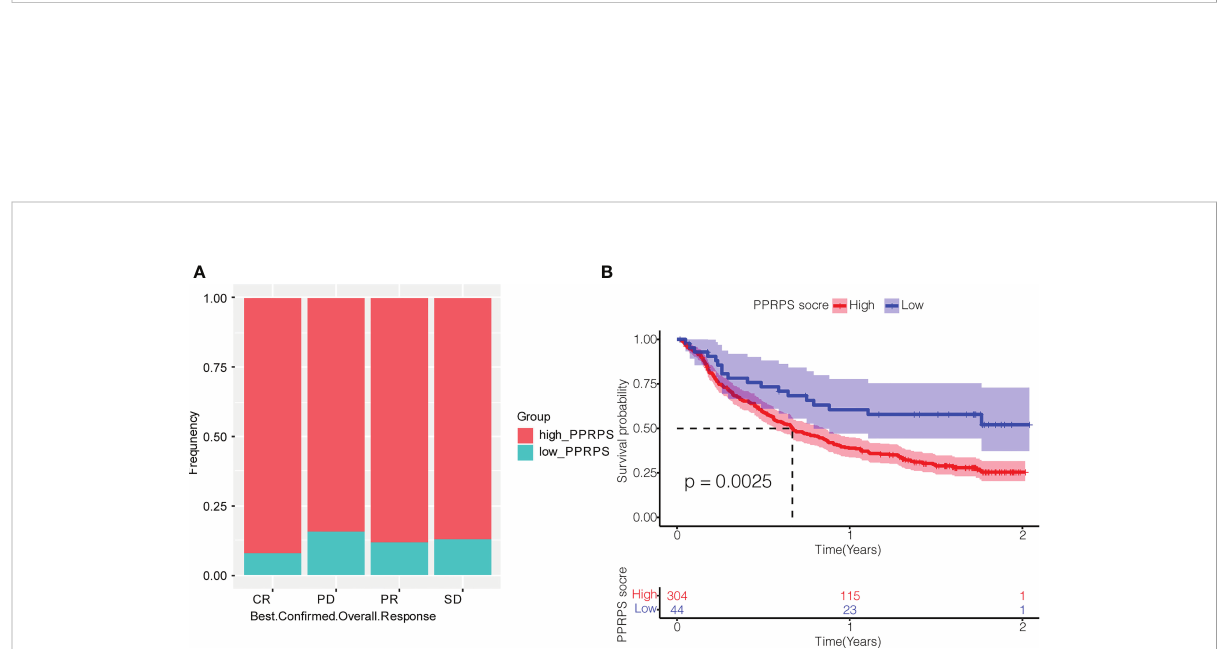
FIGURE 8 Effect of Pan-PCDs on anti-PD-L1 immunotherapy for bladder cancer. (A) Evaluation of the best overall response. Con fi rmation of CR, PD, PR, and SD in the low- and high-PPRPS groups. CR, complete response; PR, partial response; SD, stable disease; PD, progressive disease. (B) Kaplan – Meier (K-M) curve of the high-PPRPS and low-PPRPS groups after anti-PD-L1 immunotherapy, demonstrating that the patients in the high-PPRPS group had a poorer prognosis than those in the low-PPRPS group (p =